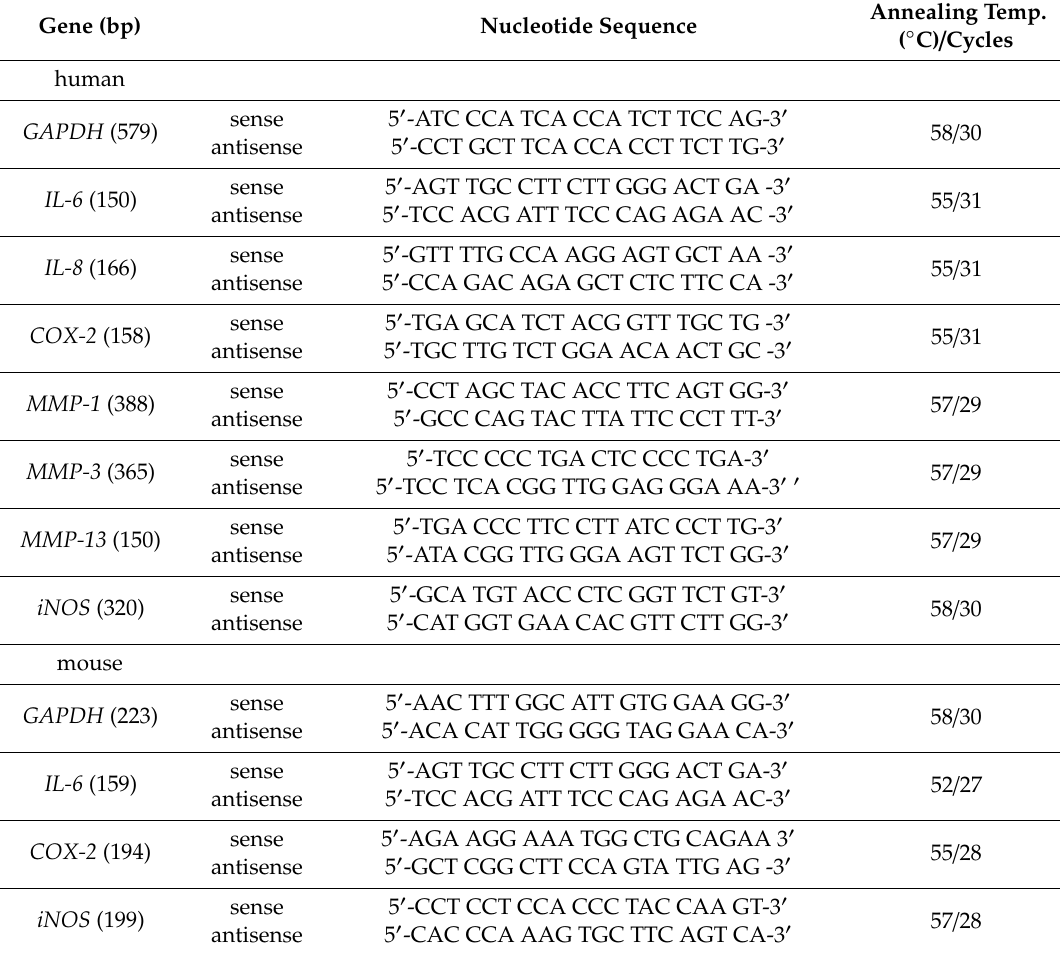
Table 1. Nucleotide sequences of primers for each gene and operating conditions of reverse transcription polymerase chain reaction (RT-PCR)